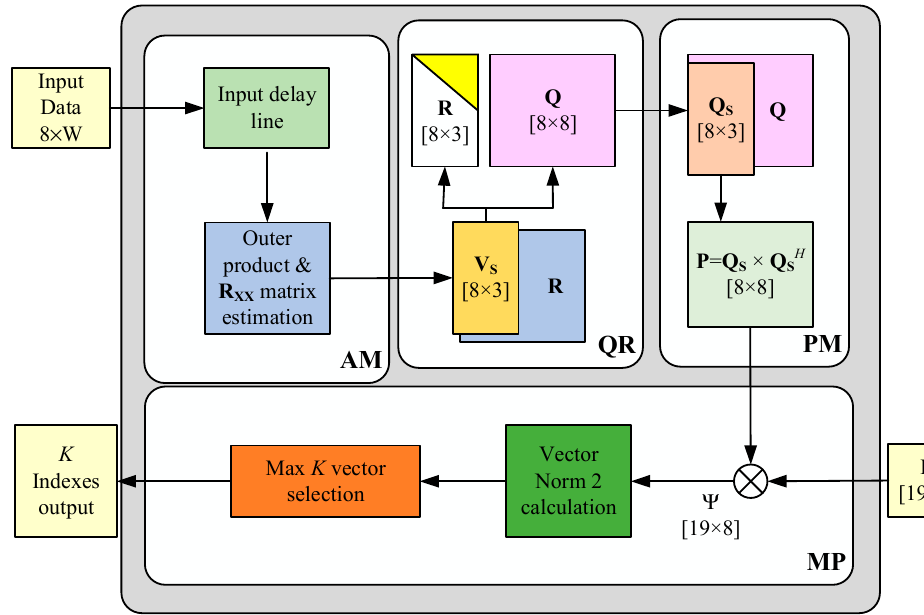
Figure 11. System block diagram of the DoA estimation hardware accelerator design.